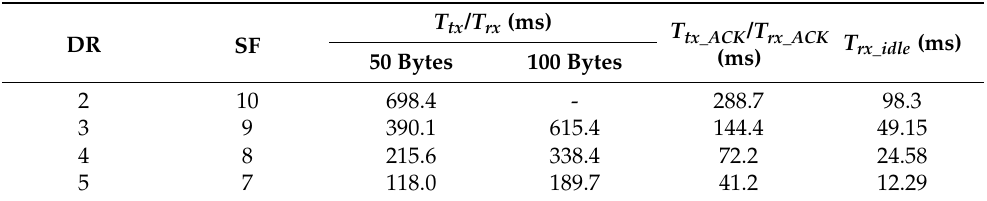
Table 4. Summary of the different transmission and reception times, based on the overall message time-on-air